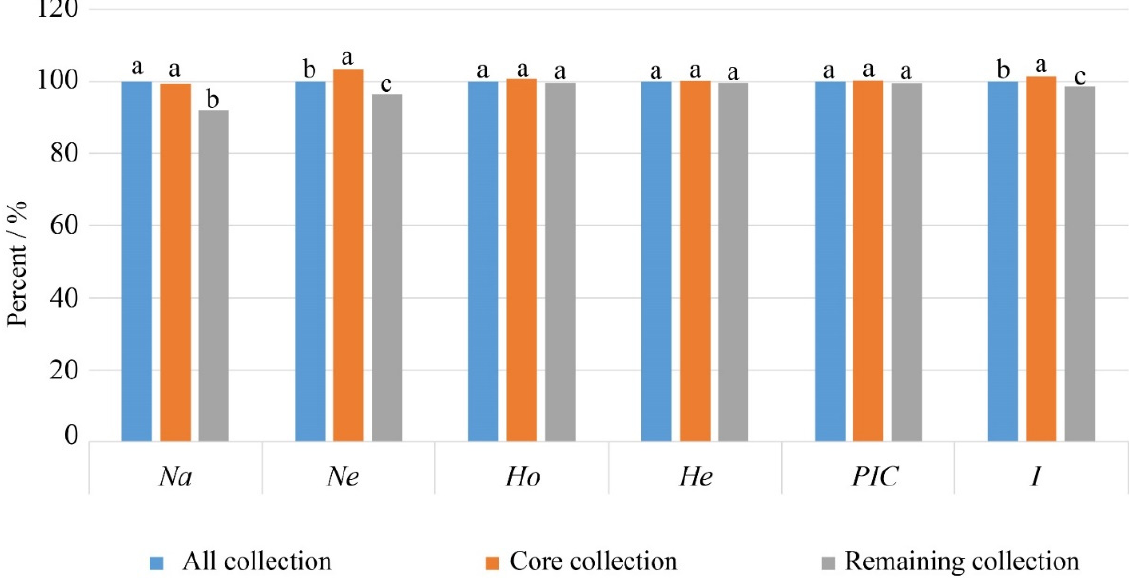
Figure 3. Genetic diversity retention ratio of the all collection, core collection, and remaining collection. There were significant differences in different letters ( p < 0.05).